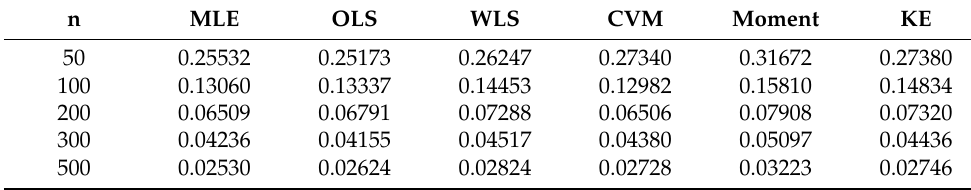
Table 2. MSEs under β = 1.2.